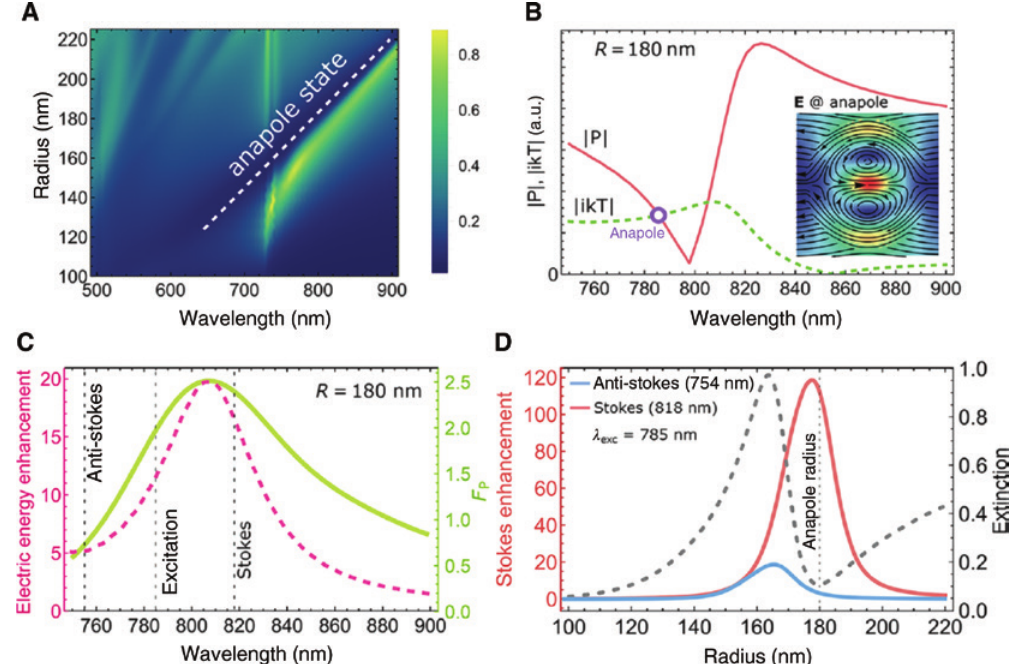
Figure 7: Electromagnetic calculations of far-field and Raman response of Si nanodisk arrays exhibiting a strong anapole state. (A) Simulated extinction (1 – transmission) spectra of Si nanodisk arrays on glass in air versus wavelength and disk radius for linearly polarized light incident normally to the substrate plane. The nanodisks are ordered in a square lattice with periodicity of 500 nm and have a constant height of 70 nm. The dashed white line is a guide for the eye indicating the anapole state dispersion. (B) Electric dipole (P, red line) and toroidal dipole (T, green dashed line) contributions to the induced electromagnetic fields inside a nanodisk of radius of 180 nm obtained from multipole decomposition. The inset shows the total local electric field distribution at the anapole wavelength of ≈ 785 nm. (C) Spectrum of volume-averaged electric field energy inside the disk and the Purcell factor FP( ω ) at the nanodisk center for the nanodisk of 180 nm radius. (D) Calculated Stokes and anti-Stokes Raman intensity of the 521 cm −1 phonon line for an excitation wavelength of 785 nm wavelength (full lines) together with the extinction amplitude at 785 nm (dashed line) versus disk radius. The intensities are normalized to the Stokes Raman intensity of an unpatterned Si film of the same thickness and to the Si volume in the calculation domain. Reprinted with permission from [41]. © Copyright 2018 American Chemical